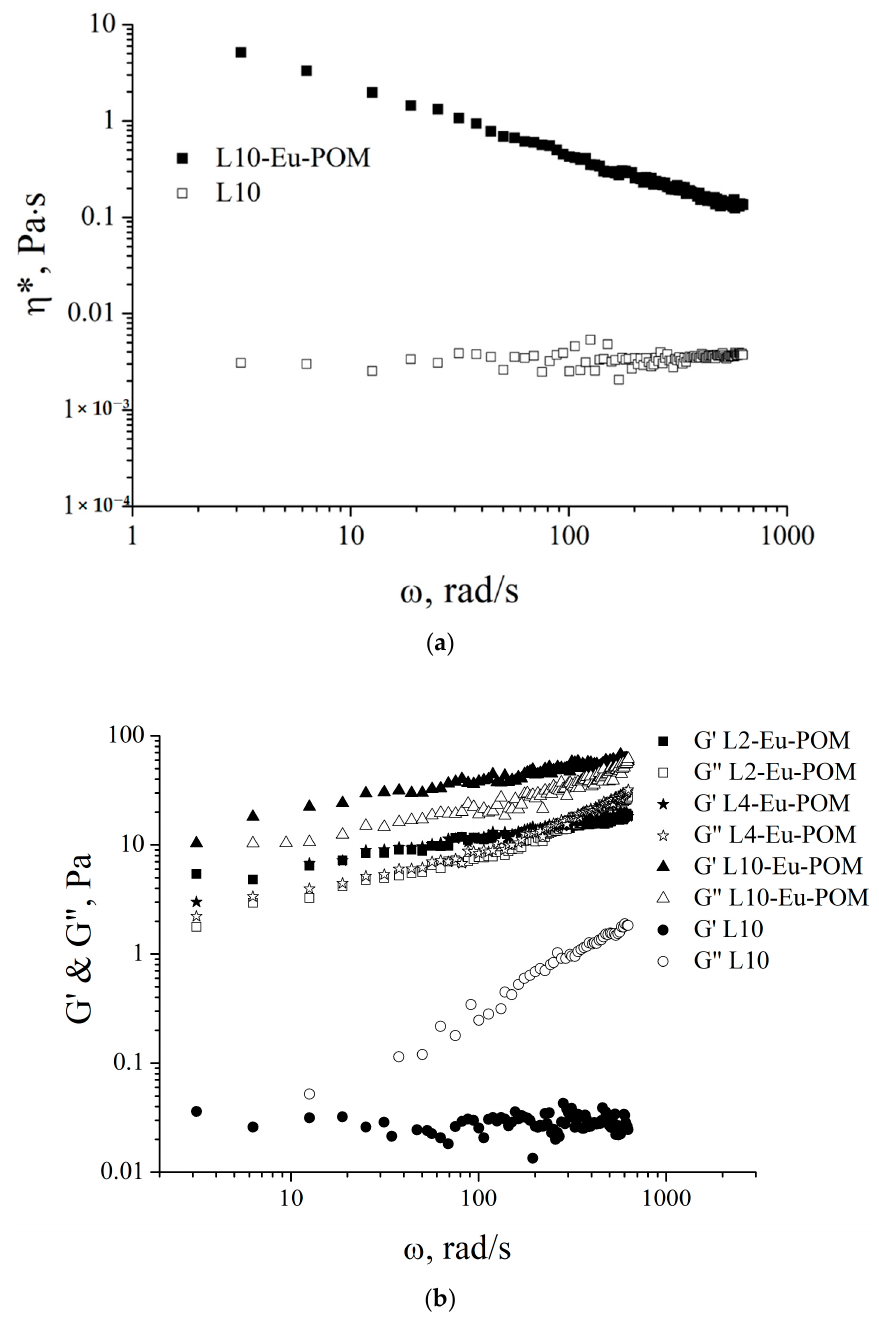
Figure 6. ( a ). Complex viscosity as a function of angular frequency for latex L10 ( □ ) and latex L10- Eu-POM ( ■ ); ( b ). G ′ and G ″ moduli as a function of angular frequency for the indicated samples. L10-Eu-POM ( (cid:4) ); ( b ). G (cid:48) and G” moduli as a function of angular frequency for the indicated